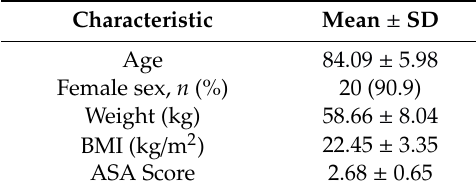
Table 1. Population